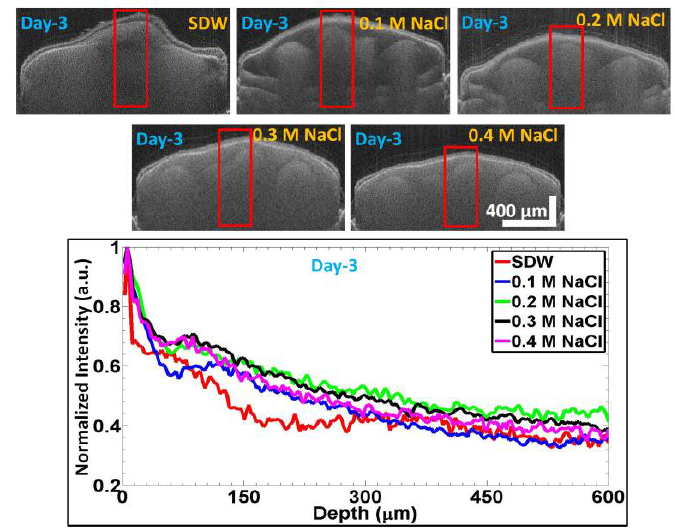
Figure 5. SS-OCT images acquired on Day 3 after priming the Capsicum annuum seeds with different solutions. The bottom figure is the respective averaged and normalized depth profile analysis plot (as discussed in Section 2.4) for SDW, 0.1 M NaCl, 0.2 M NaCl, 0.3 M NaCl, and 0.4 M NaCl, which are correspondingly shown with colors of red, blue, green, black, and magenta plots.